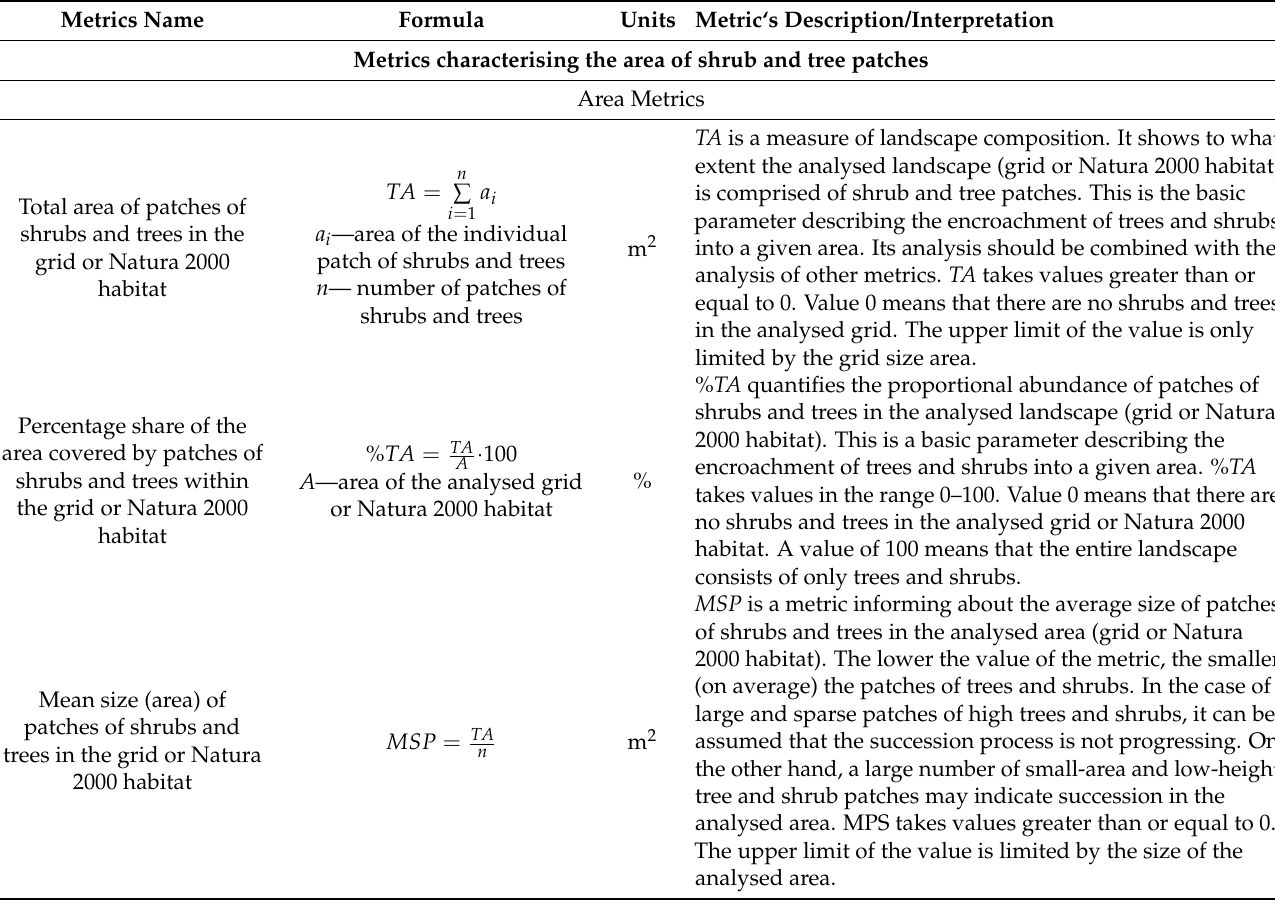
Table A5. Metrics characterising the area and the height structure of shrubs and trees patches in the grid or tura 2000